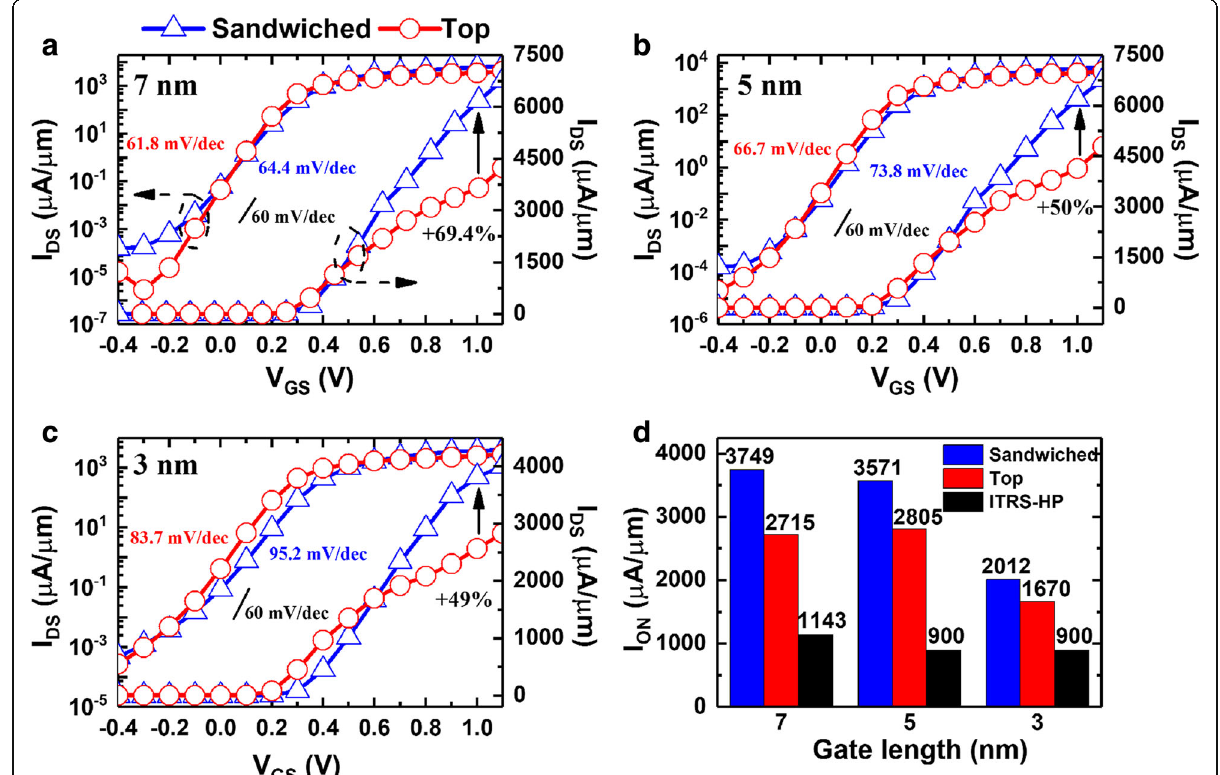
Fig. 5 Transfer characteristics of InSe FETs at node. a 2019, b 2021, and c 2024 nodes, respectively. d Comparisons of I ON following HP requirement of